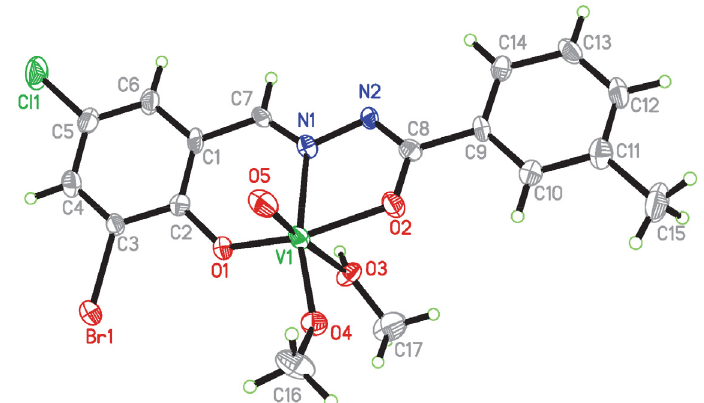
Figure 4. A perspective view of complex 2 with the atom labeling scheme. Thermal ellipsoids are drawn at the 30% probability level.